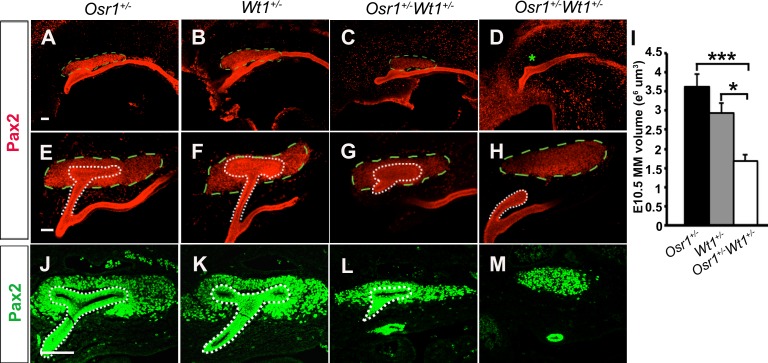
Osr1+/-Wt1+/- embryos exhibit defects in metanephric mesenchyme.(A-H) Whole mount immunofluorescent staining for Pax2 (red) at E10.5 (A-D) and E11.5 (E-H). The white dot line outlines the ureteric bud epithelium. The green dashed line outlines the MM domain. Asterisk in D indicates that no condensed Pax2+ MM domain was detected. (I) Quantification of MM volume at E10.5 (n = 10). The MM volume does not include UB or duct epithelium. Error bar represent SEM. *, p < 0.05; ***, p < 0.005. (J-M) Immunofluorescent staining for Pax2 (green) in E11.5 sections. Scale bar, 100 μm.